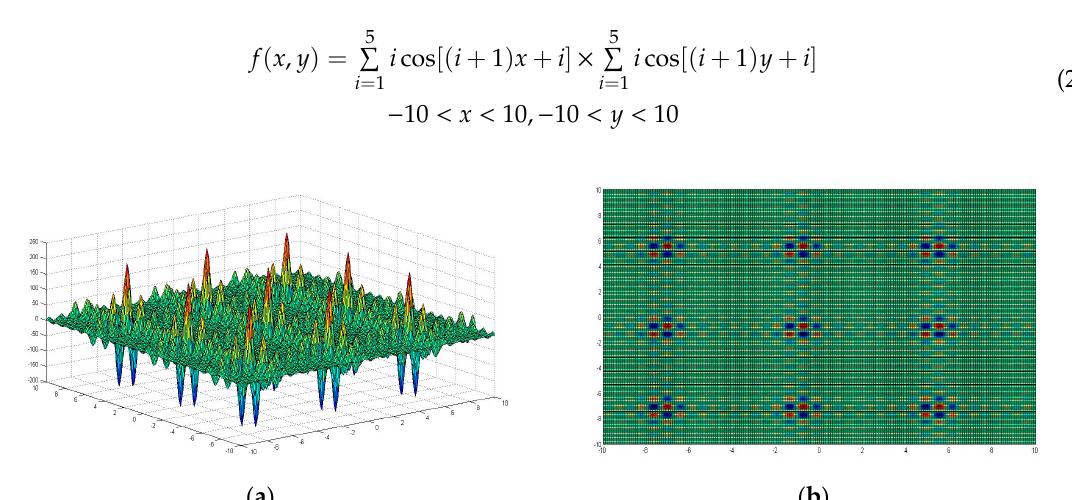
Figure 2. ( a ) Shubert function simulation view 1 (along X-axis and Y-axis); and ( b ) Shubert function simulation view 2 (along Z-axis).